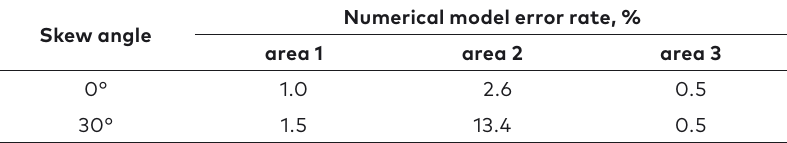
Table 1. Values of RMSE for water level profiles numerically